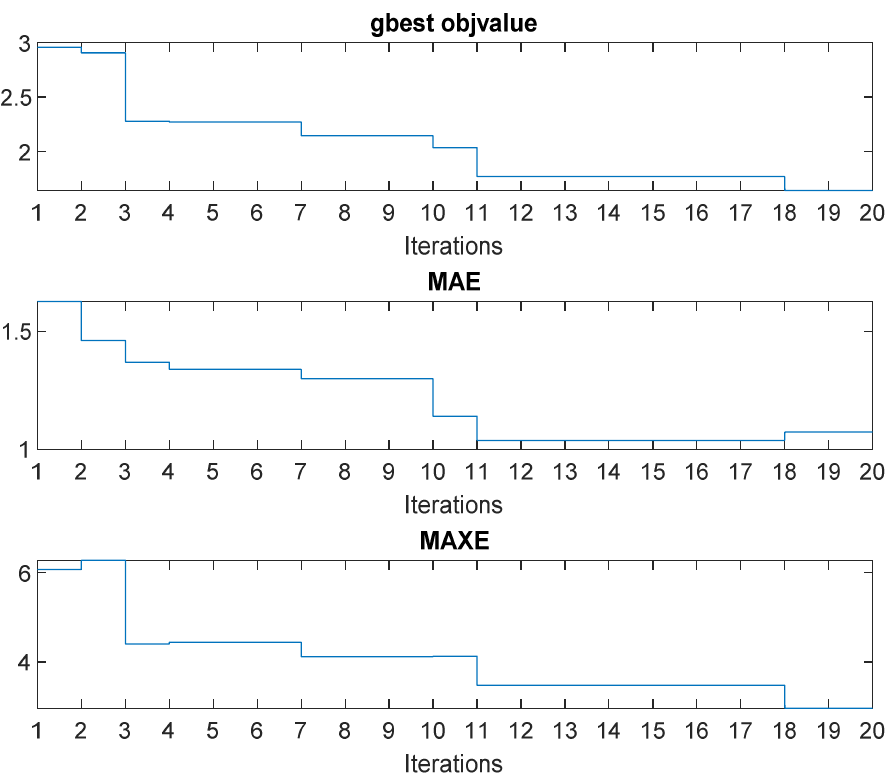
Figure 20. PSO iterative parameters.